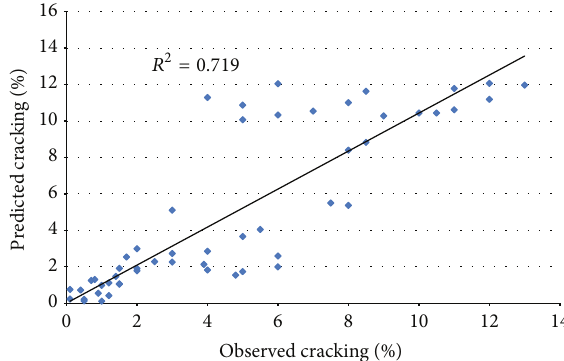
Figure 2: Comparison between predicted and observed cracking values based on the out of sample data.